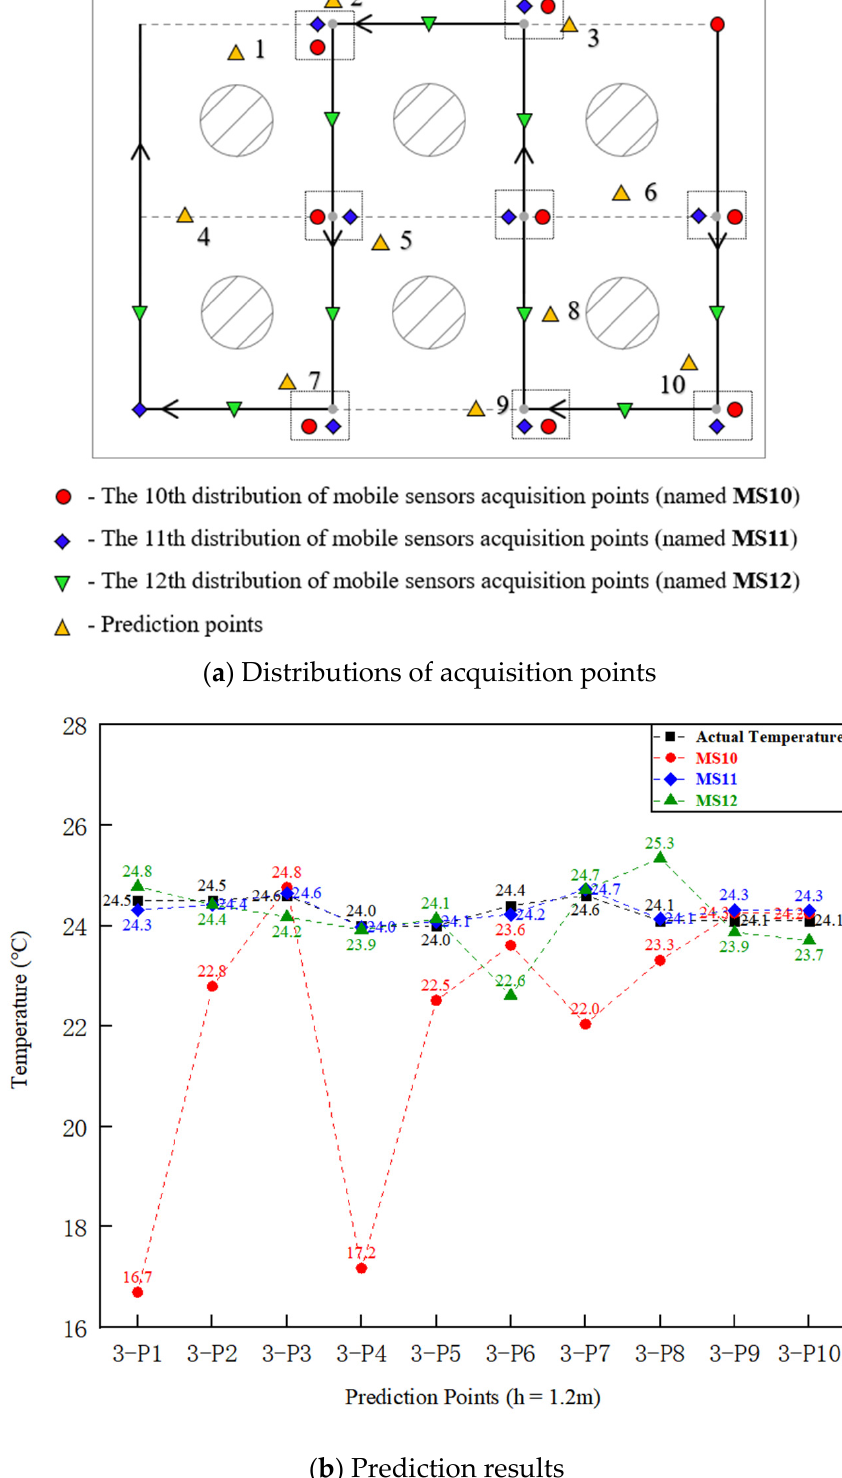
Figure 14. Prediction of mobile sensors with acquisition distance of 4.0 m.